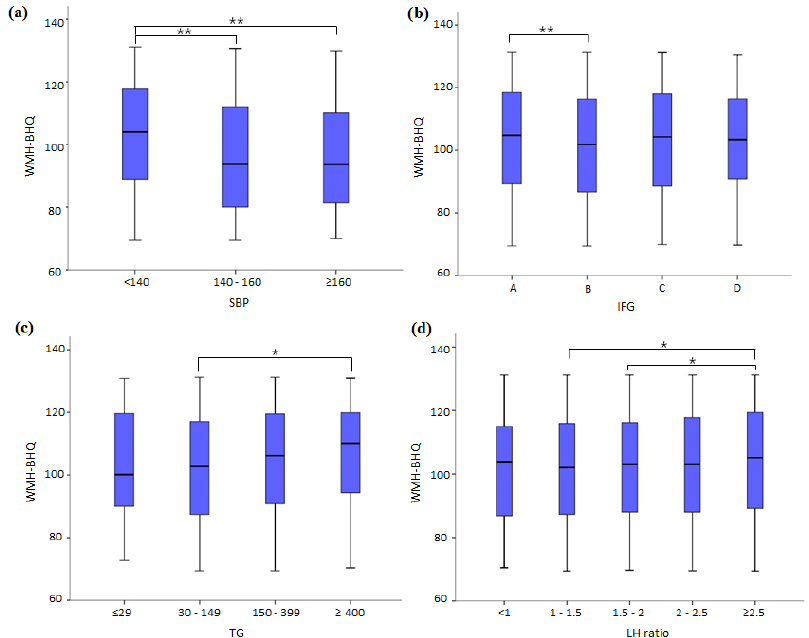
Figure 4. Box plots of WMH-BHQ with no medical history according to ( a ) systolic BP (SBP), ( b ) ( b ) triglyceride (TG), ( c ) impaired fasting glucose (IFG) criteria, and d) the ratios of LDL to HDL (LH ratio). ( d ) A: fasting blood sugar (FBS) < 100 and HbA1c < 5.6; B: 100 ≤ FBS < 110 or 5.6 ≤ HbA1c <